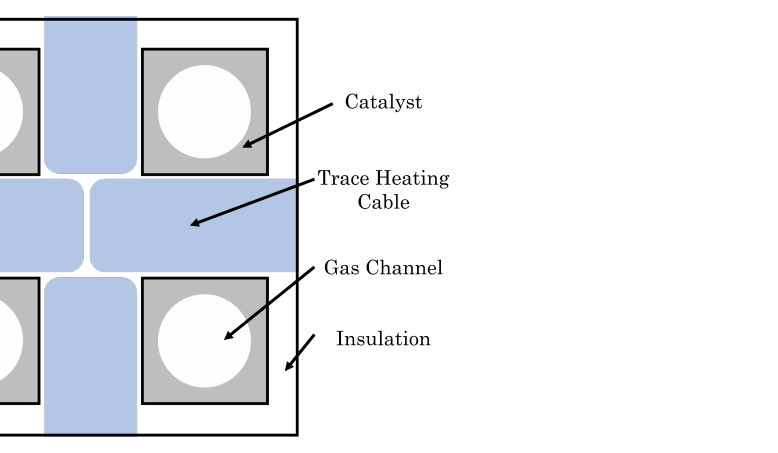
Figure 12. A notional cross-section of the catalytic ammonia cracker proposed in Section 2.8 with cell walls thick enough to accommodate electrical trace